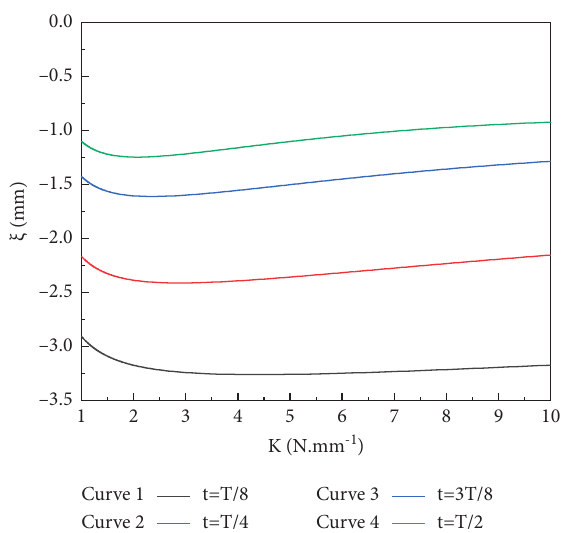
Figure 9: The relationship curve between spring stiffness K and ξ .